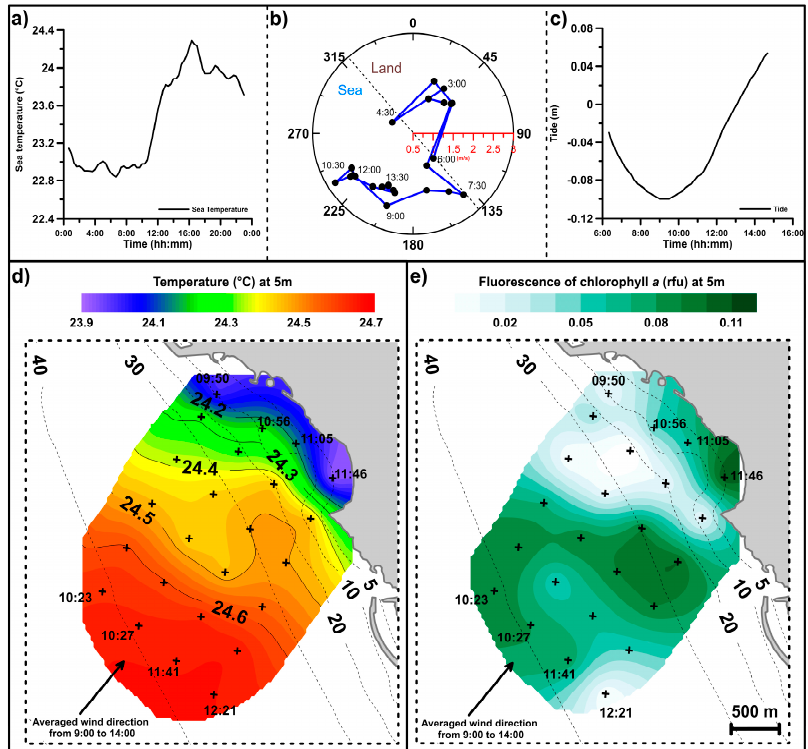
Figure 8. Sea surface temperature ( a ) at WQMS harbor, wind hodograph ( b ) and tide ( c ). Maps